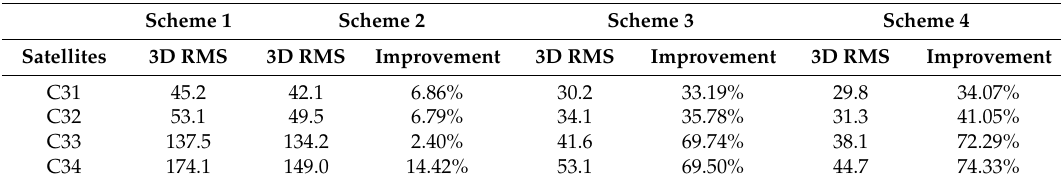
Table 7. Orbit 3D RMS (cm) of different schemes and its improvement.